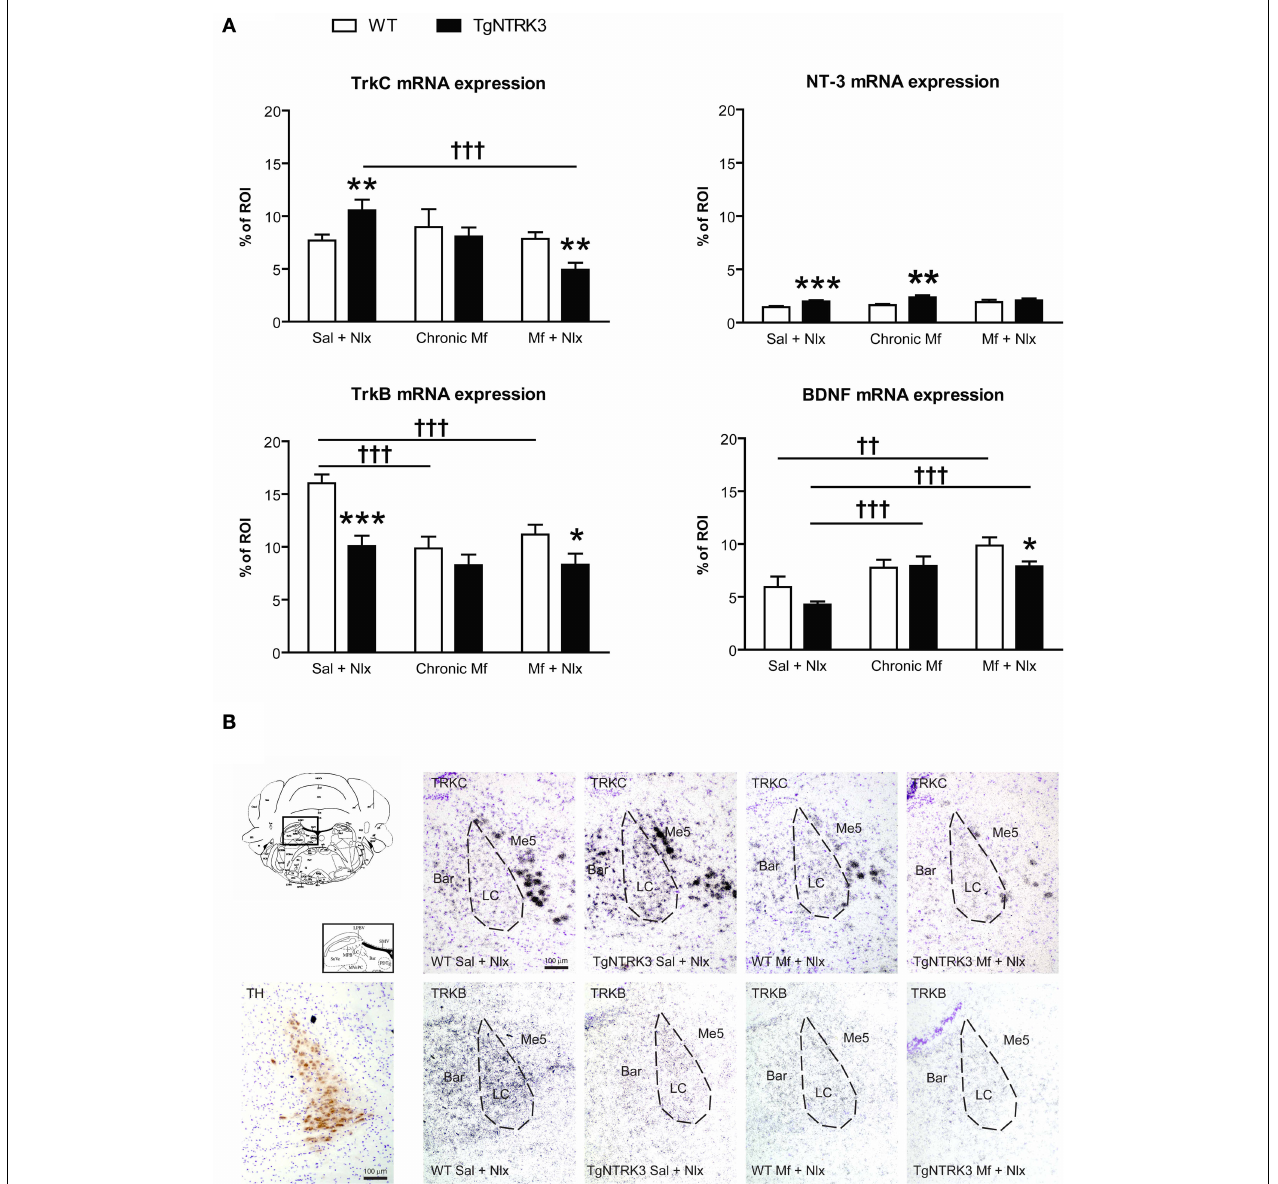
FIGURE 5 | In situ hybridization of TrkC, TrkB and their ligands after chronic morphine administration and precipitated withdrawal. (A) Expression of TrkC, NT-3, TrkB and BDNF given as percentage of intensity for the region of interest (% of ROI) in WT (white bars) and TgNTRK3 (black bars) mice. (B) Diagram showing the locus coeruleus (LC) localization and photomicrographs of consecutive 14 µm coronal sections labeled with TH antibody (1:8000; Sigma, MO, USA) served to